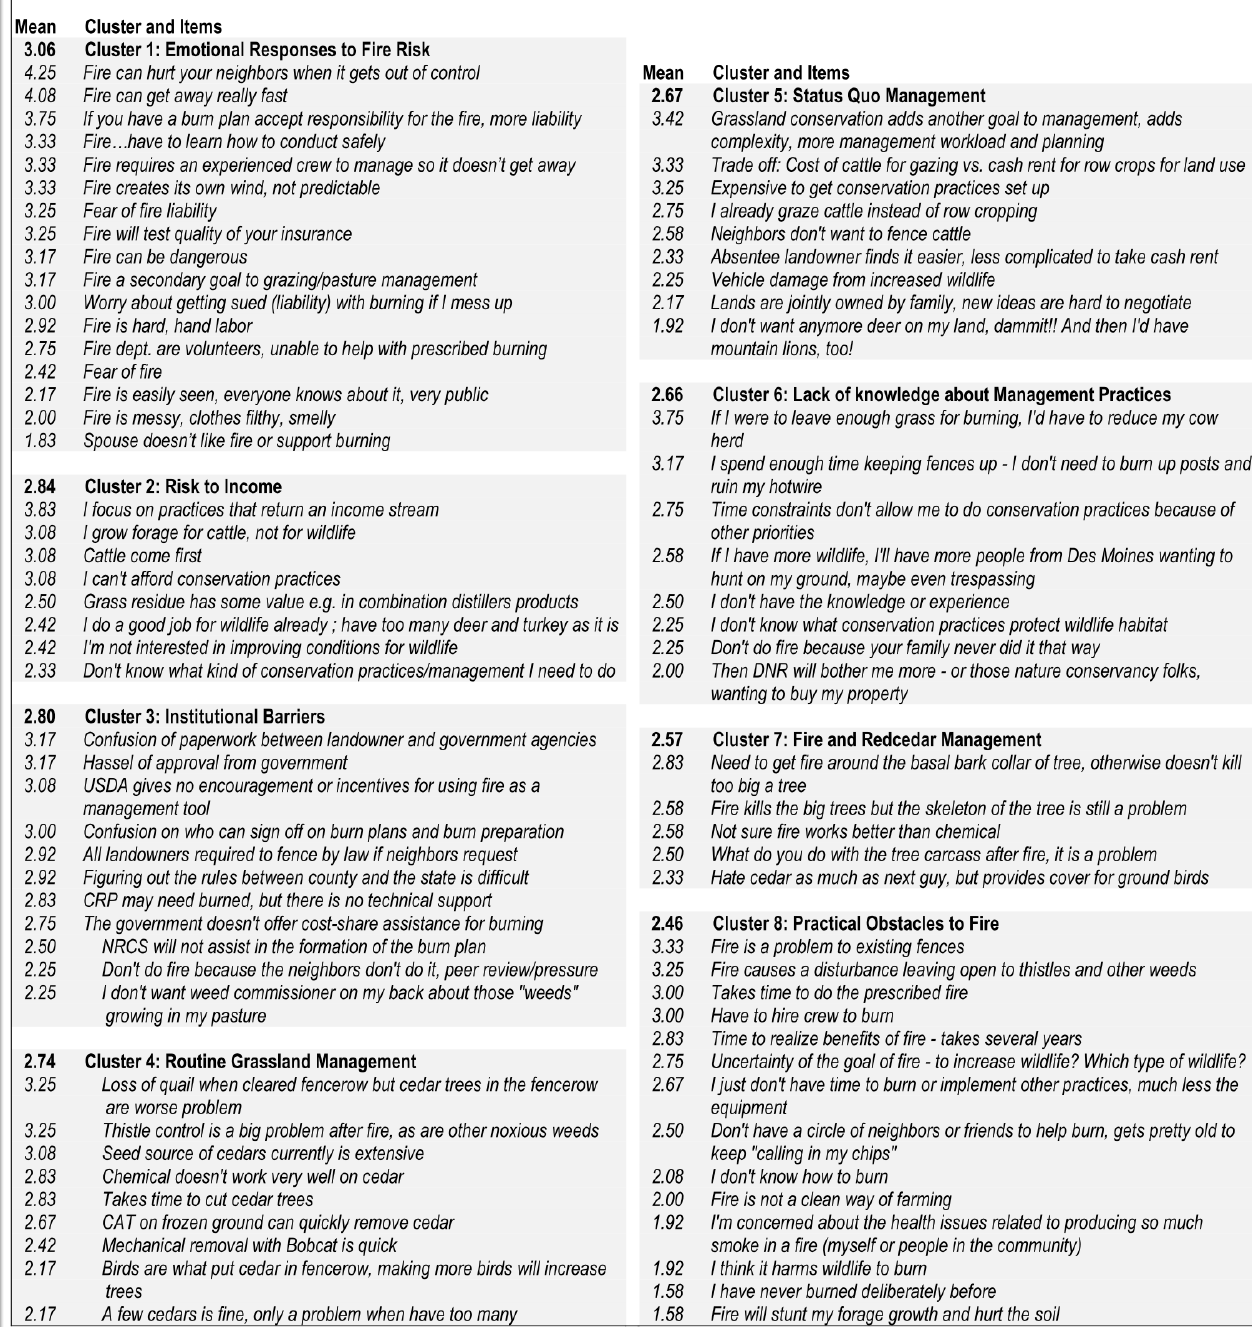
Fig. 3 . Importance ratings of Grand River Grassland landowners for the statement “One reason conservation practices that improve conditions for wildlife that depend on grassland habitats are not implemented on my land or my neighbors' lands is . . . ”, where 1 = not at all important, 2 = a little important, 3 = moderately important, 4 = highly important, or 5 = extremely important. Grand mean in